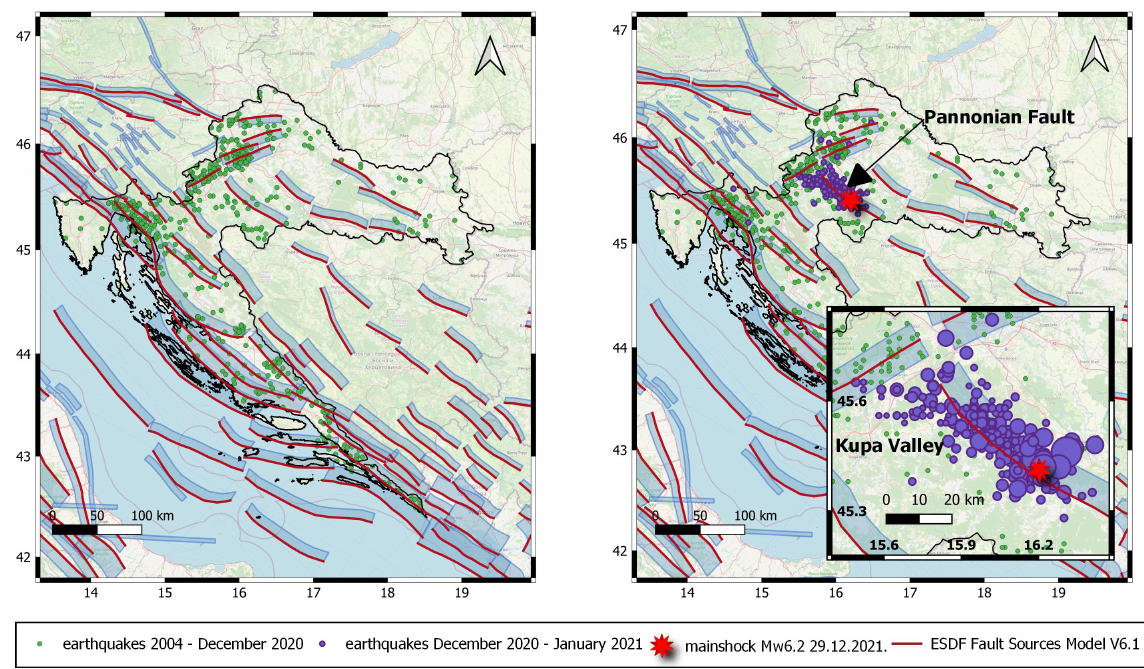
Figure 2. Figure displays seismic activity on the Croatian territory in the period between 1 January 2004 and 15 December 2020. ( left ) and in the period between 15 December 2020 and 7 January 2021 ( right ). Earthquake data was obtained from EMSC